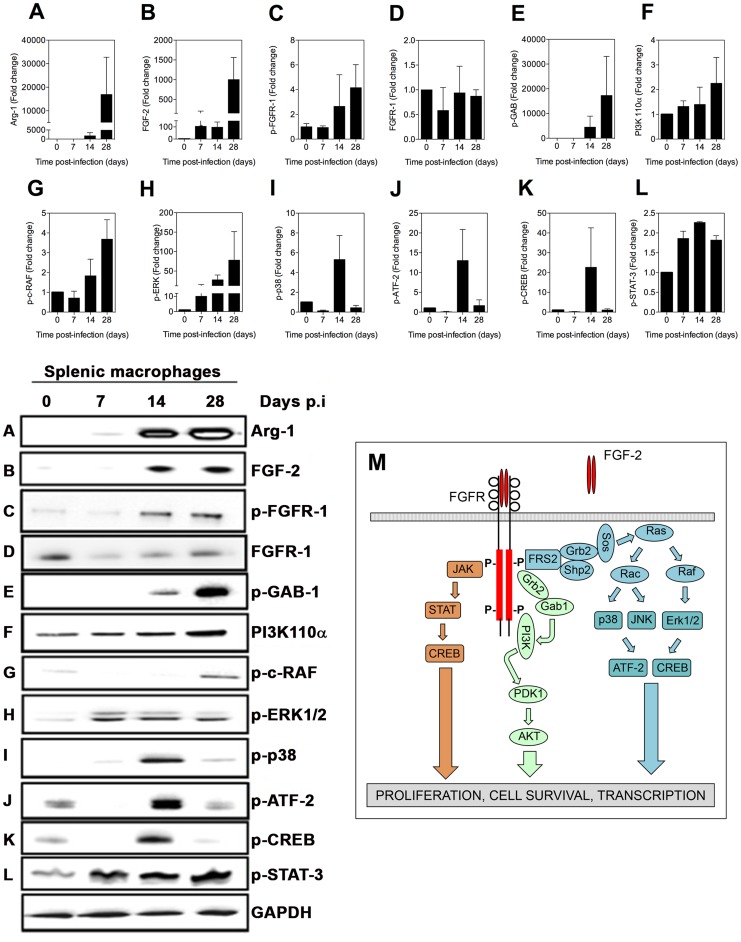
Activation of signaling proteins in the FGFR canonical pathway in splenic macrophages from hamsters with VL.(A–L) Splenic macrophages were isolated by adherence from the spleens of uninfected hamsters (time 0) or hamsters infected for 7, 14, and 28 days and whole cell lysates probed with antibodies directed against arg1 (panel A, representative blot A) or members of the FGF signaling pathway (panels and representative blots B–L). Bars represent the fold change with reference to control cells of uninfected hamsters calculated by densitometry analysis of immunoblot bands from samples pooled from 1–4 hamsters per determination from 2–3 independent experiments. M) Simplified schematic of the canonical FGF signaling pathway for reference.